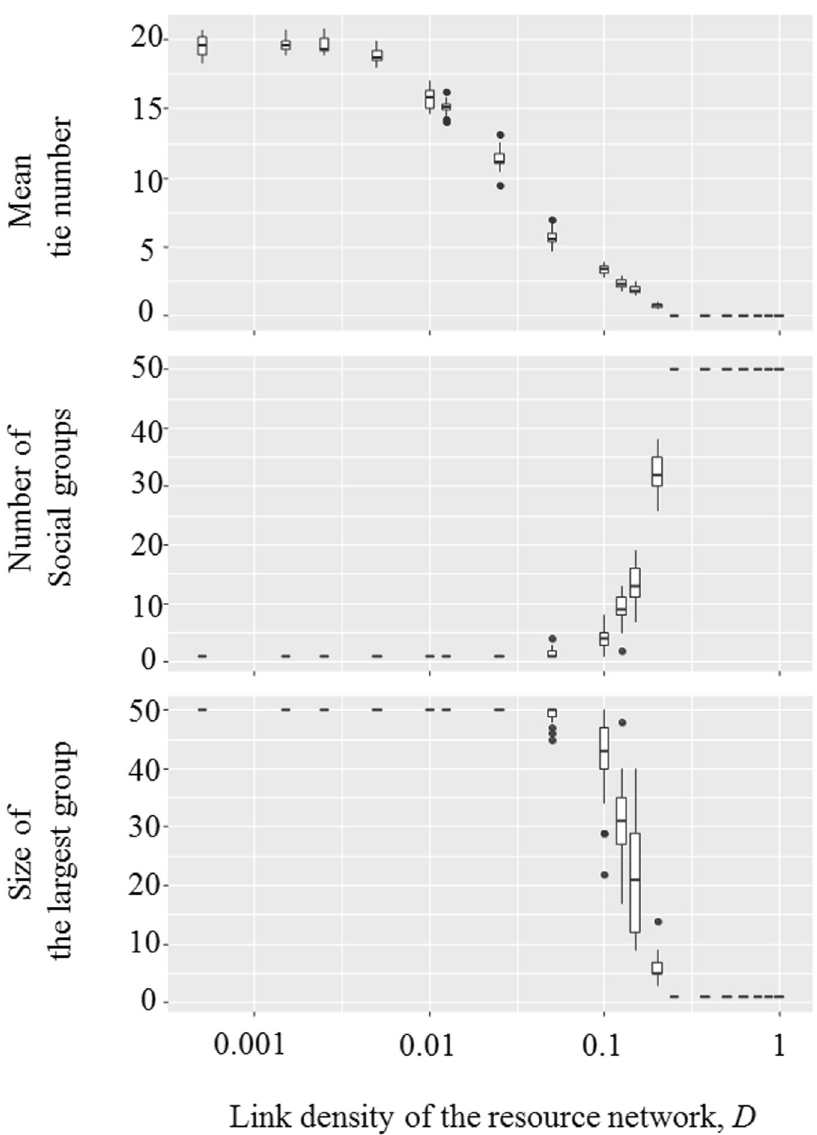
Fig. 16 Box plots showing changes in the actors ’ social network for various values of D . Values for other parameters are: N = 50, M = 4000, G = 100, E = 1000, T = 2000. For each combination of parameter values, the model was simulated 100